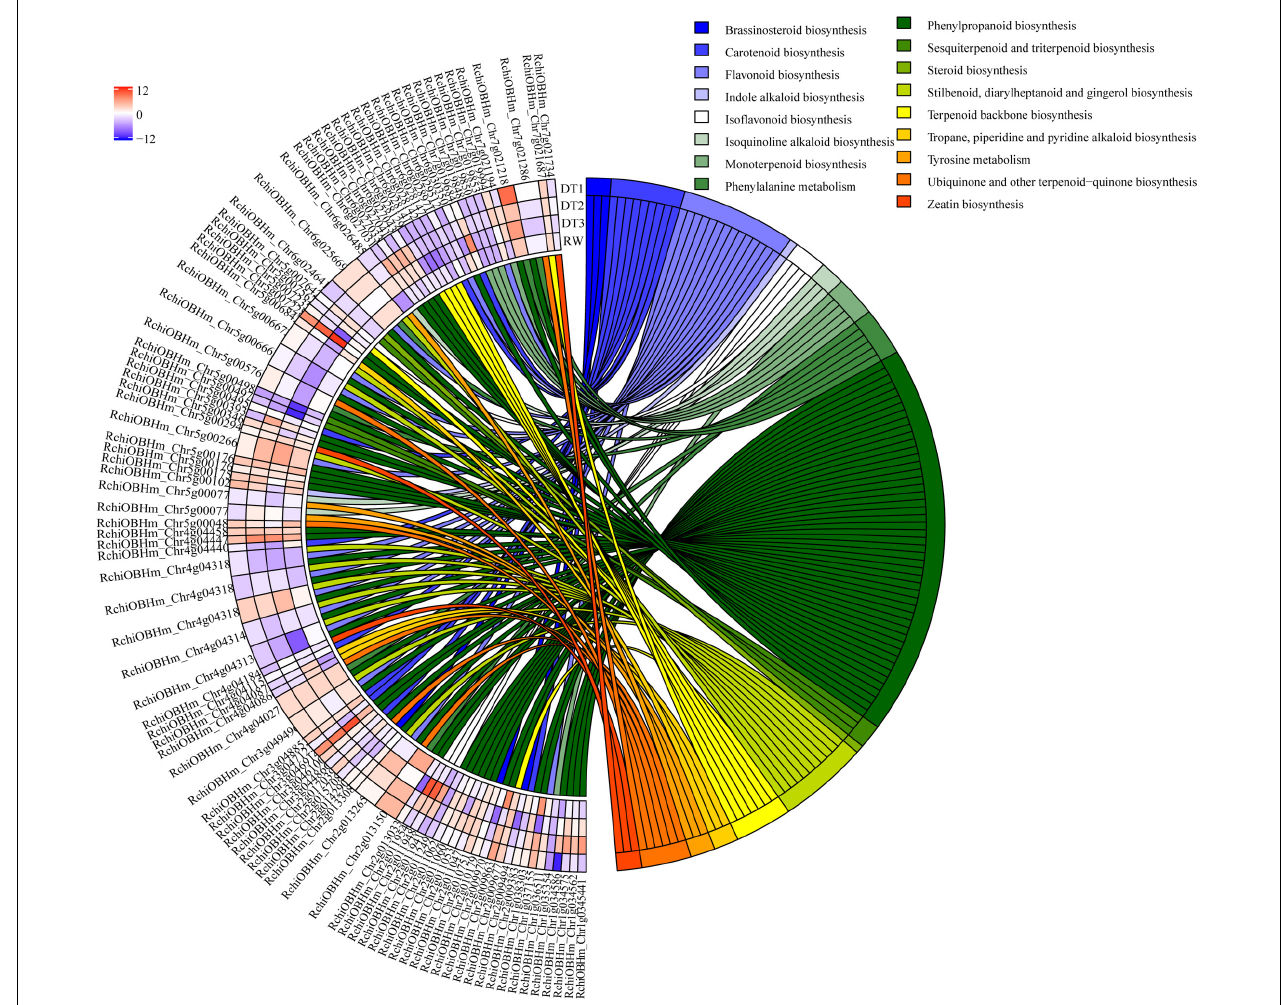
FIGURE 4 | KEGG enrichment of differentially expressed genes involved in secondary